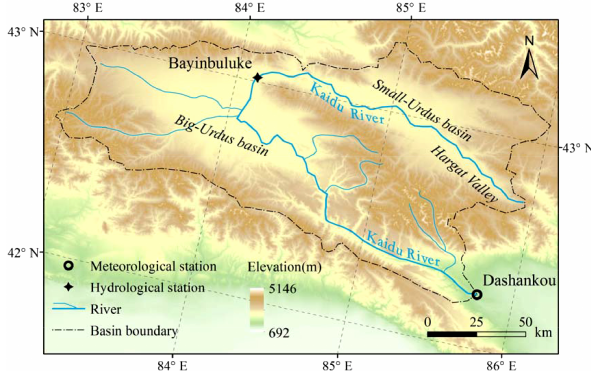
Figure 1. Location of the Kaidu River, northwest